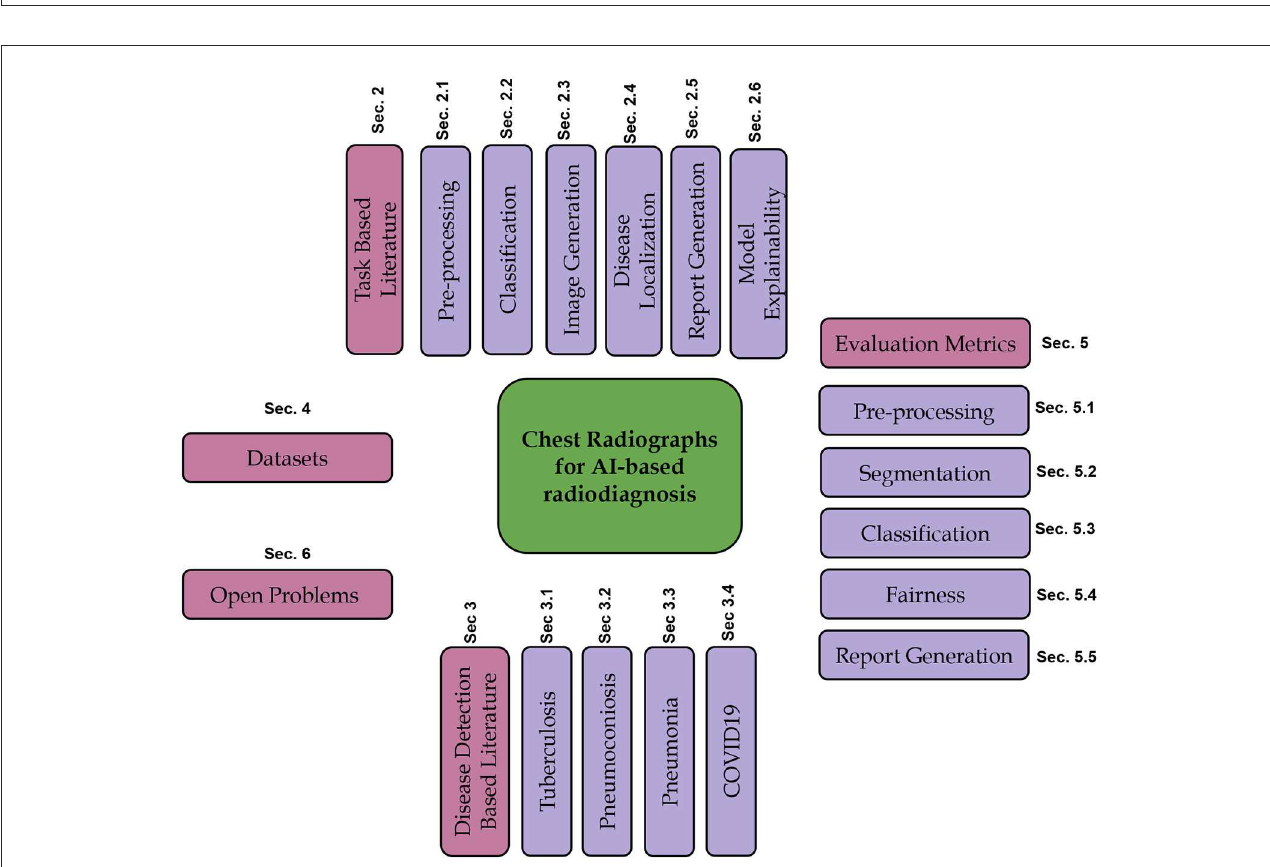
FIGURE4 Illustrating the schematic structure of the